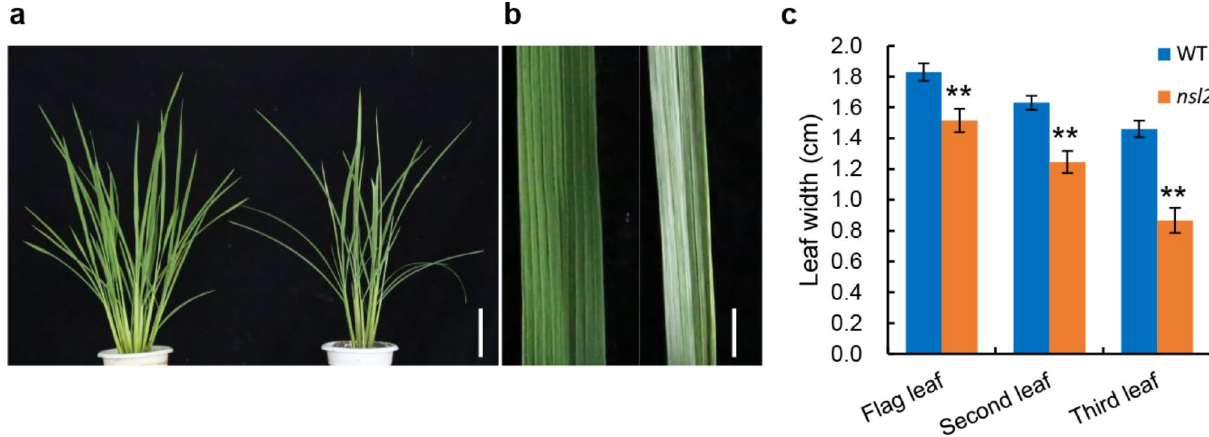
Fig. 1 Phenotypic characteristics of the nsl2 mutant. a : Phenotypes of the WT (left) and nsl2 (right) at the tillering stage. b : Differences of leaf shape and leaf color in the adaxial-side between WT (left) and nsl2 (right). c : Comparison leaf width of the upper three leaves between WT and nsl2 . Bars ( a ) 10 cm; ( b ) 1